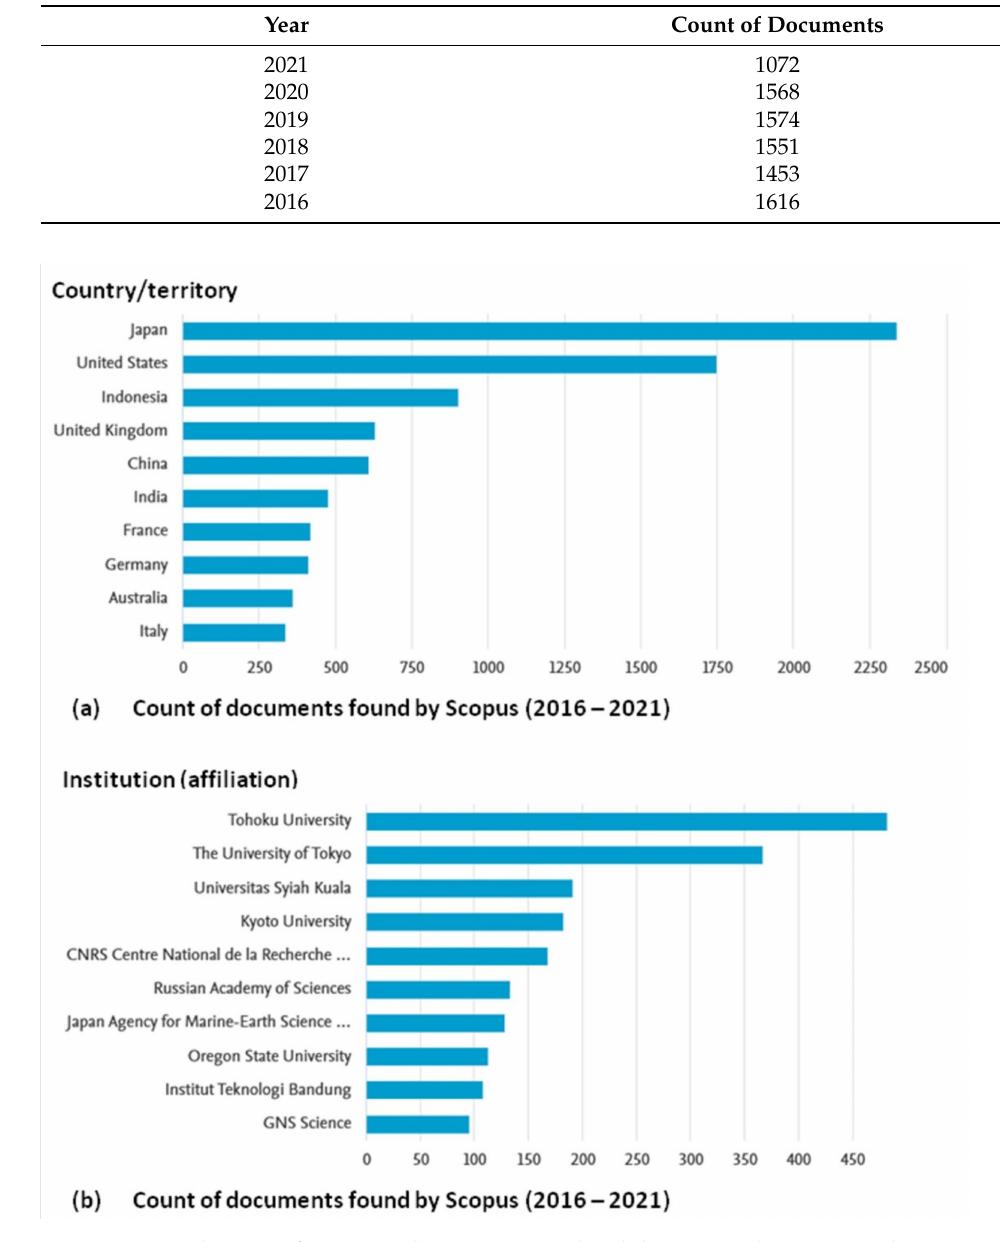
Figure 1. Visualisation of statistics about tsunami-related documents (Scopus search